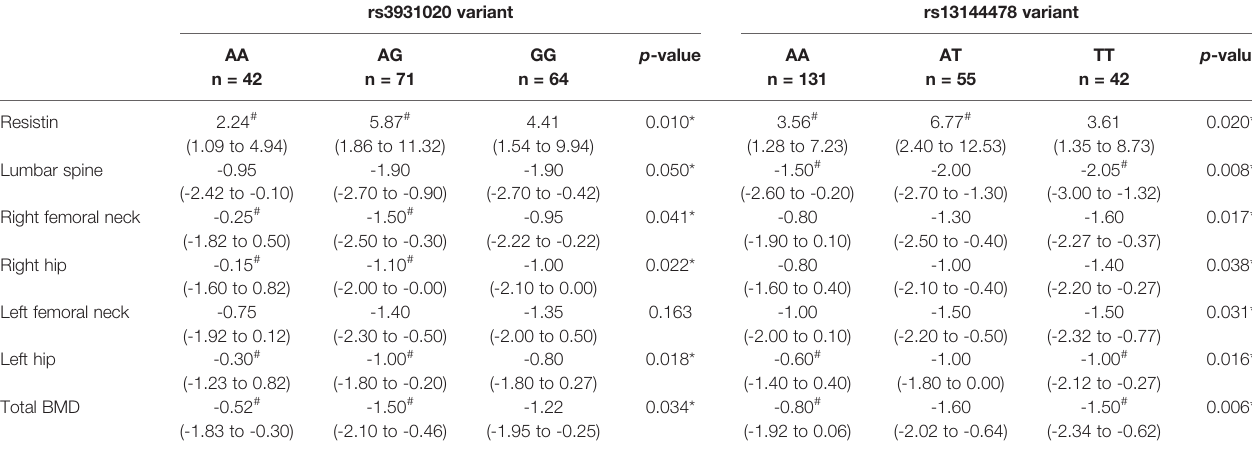
TABLE 3 | Serum resistin levels and BMD in postmenopausal women with rs3931020 and rs13144478 single nucleotide